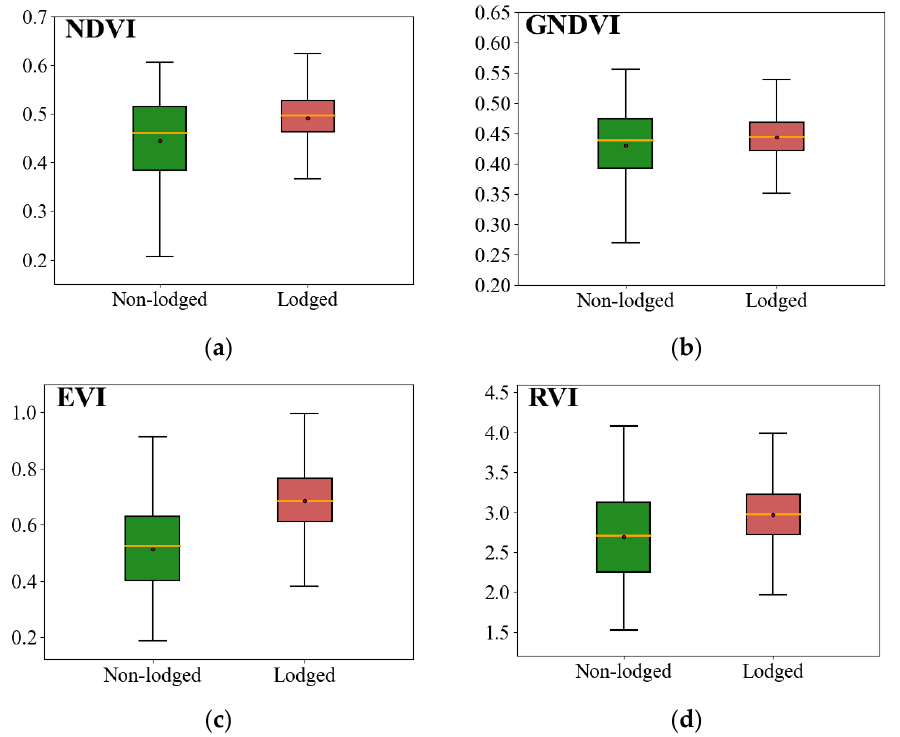
Figure 10. Boxplots of four types of vegetation indexes across lodged and non-lodged wheat: ( a ) NDVI; ( b ) GNDVI; ( c ) EVI; ( d ) RVI. The orange line indicates the median, the red point represents the mean value, and the top and bottom edges of the box represent the upper quartile and lower quartile, respectively.